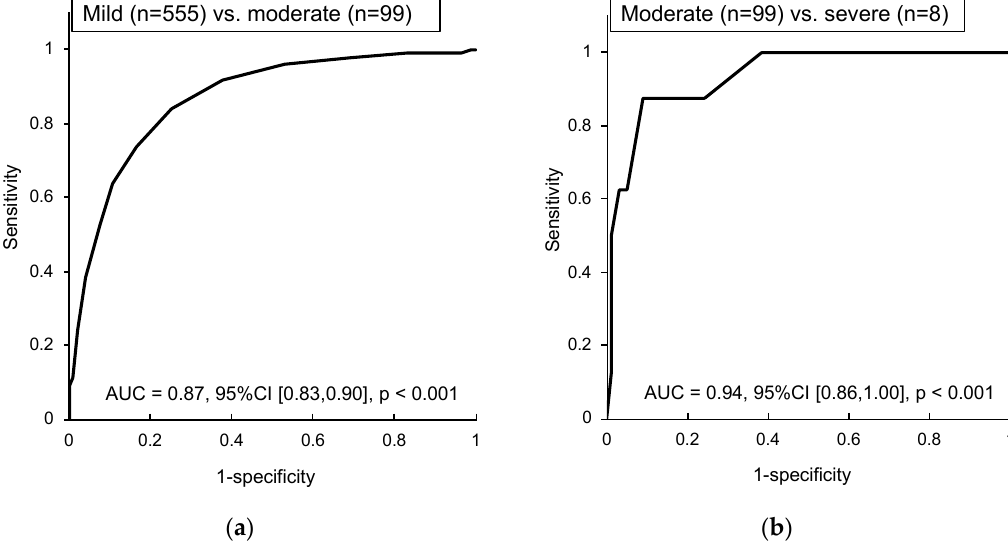
Table 3. Cuto ff scores of the AIS for